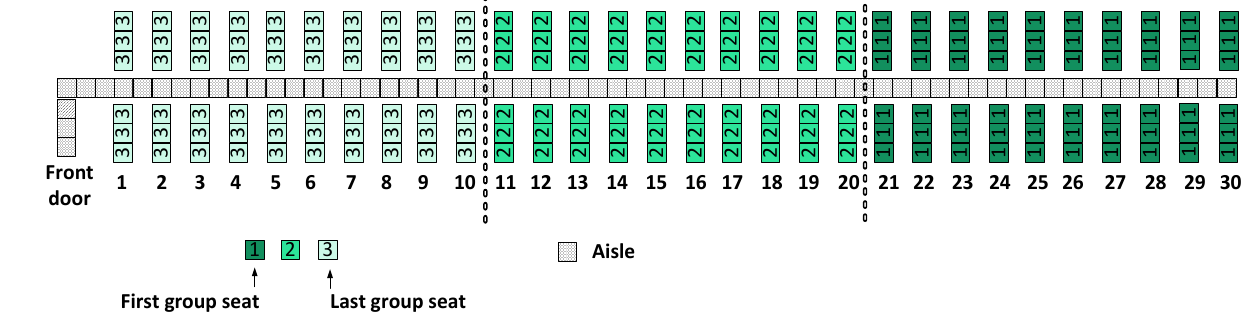
Figure 3. Back-to-front-by-3-groups.